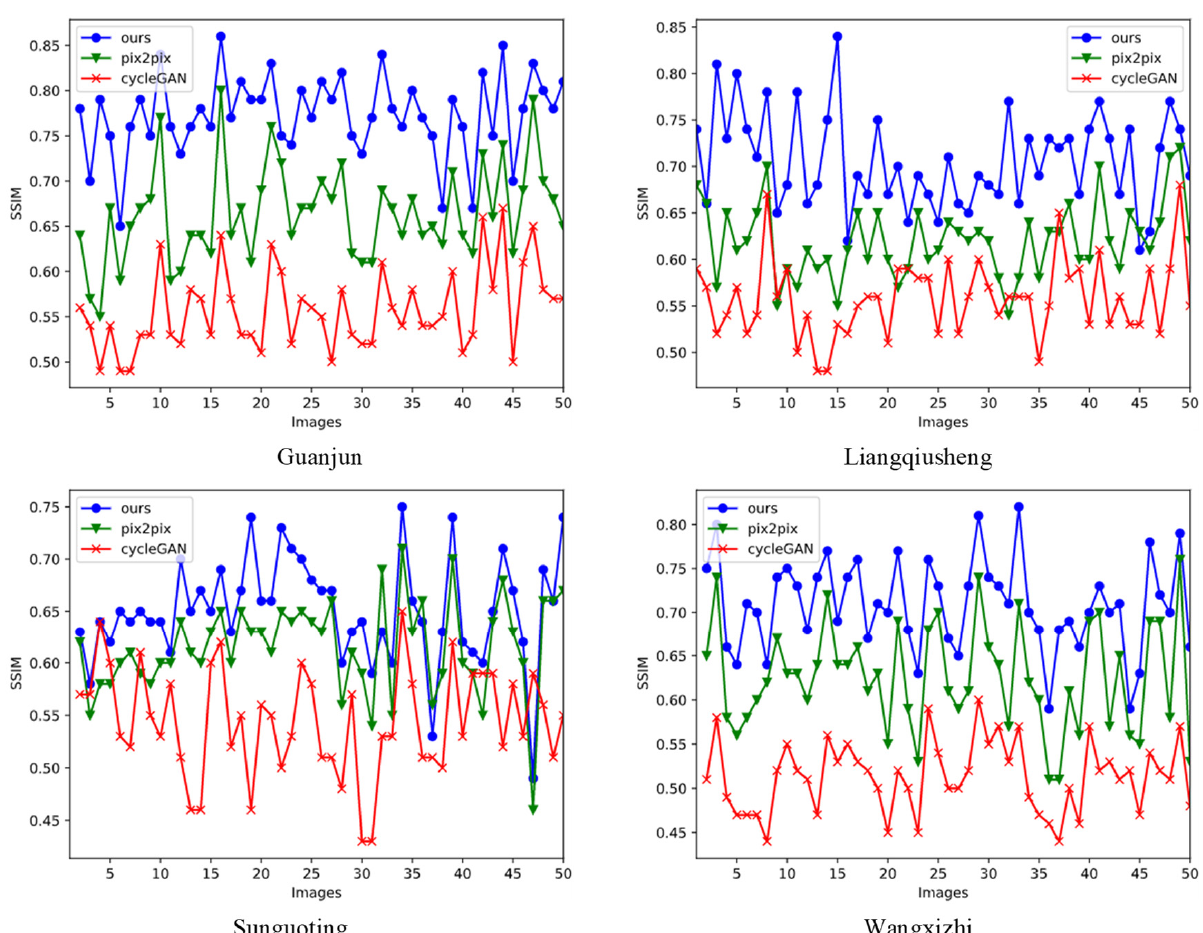
Figure 8. Partially generated image SSIM value line graph. Figure 7. Partially generated image SSIM value line graph.